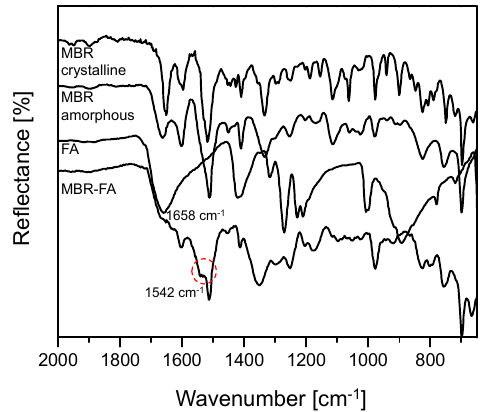
Figure 4. ATR-FTIR spectra for MBR-FA co-amorphous, MBR amorphous, MBR crystalline solid, and FA.